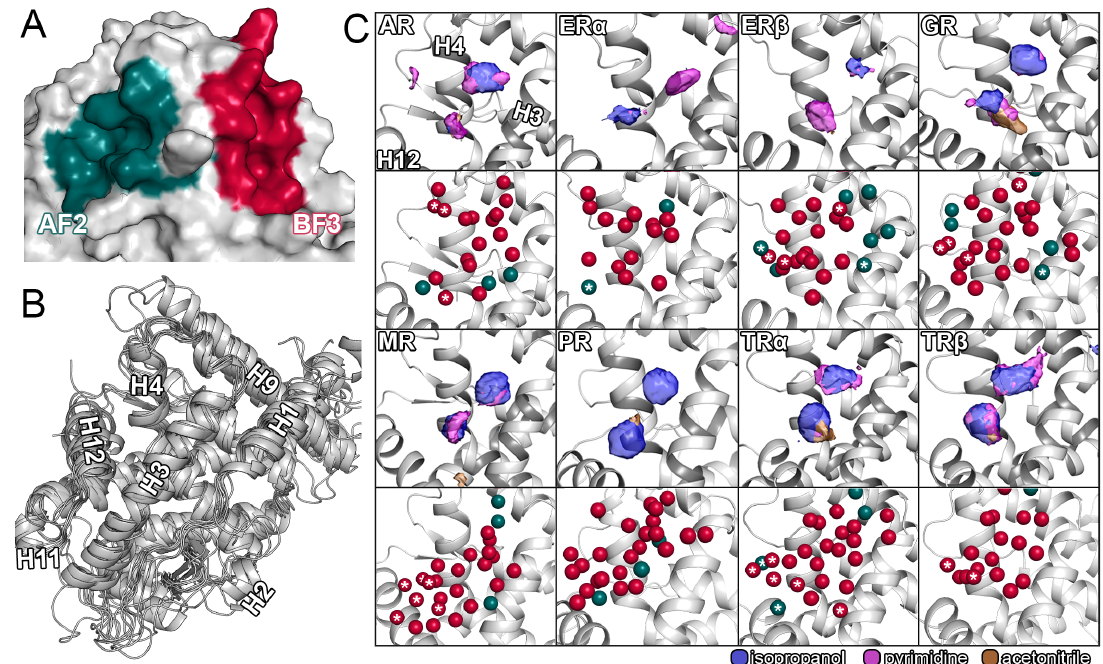
Figure 1. Structural overview, results from cosolvent simulations, and hydration site prediction for the AF-2 site. ( A ) AF-2 and BF-3 sites of the androgen receptor (PDB ID: 3L3X). ( B ) Structural alignment of AR, ER α , ER β , GR, MR, PR, TR α , and TR α . Secondary structure elements were assigned according to Tan and colleagues [44]. ( C ) For each receptor, the results of cosolvent simulations (upper part) and hydration site prediction (lower part) from WATSite for the AF-2 site are given. The color scheme for the cosolvent densities is given below the figure. The densities are shown at an isovalue of 12. Water molecules, that were found to be conserved based on the crystal structure analysis were colored in pine green and water molecules with a negative enthalpy ( ∆ H < − 1.0 kcal/mol) were indicated with